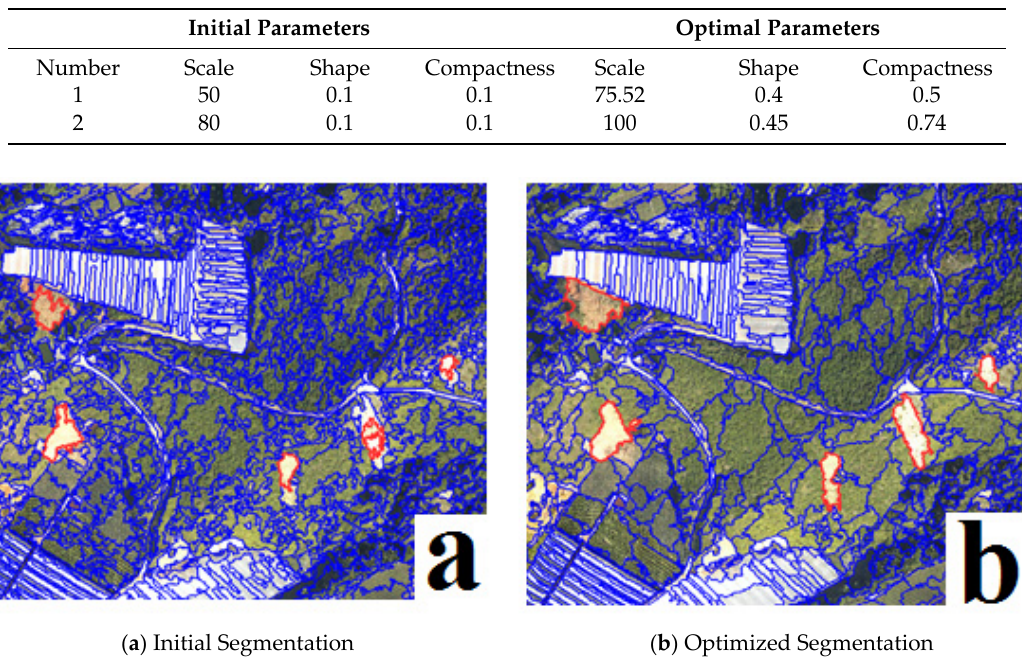
Figure 8. Parameter optimization of the multiresolution segmentation algorithm: ( a ) initial segmentation and ( b ) optimized segmentation.